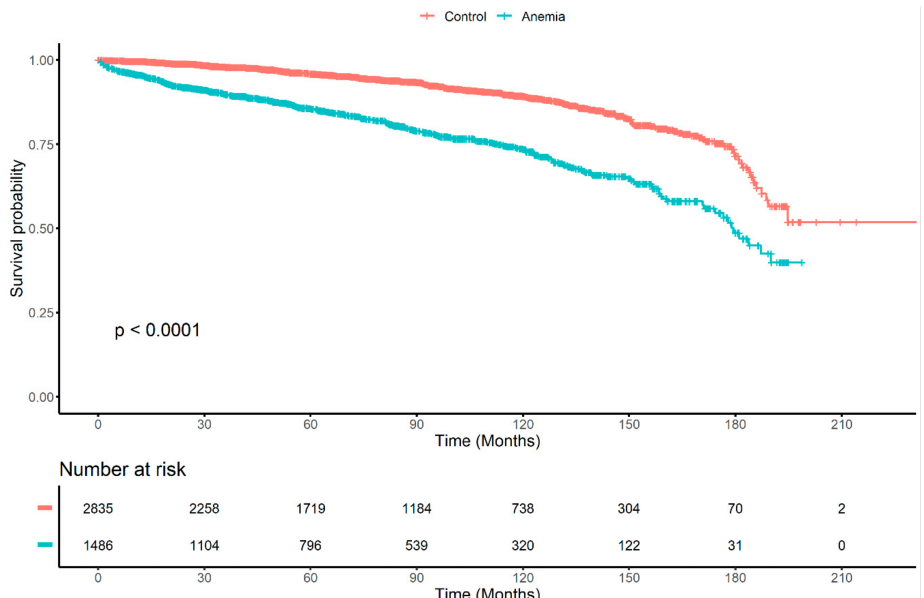
Figure 4. Kaplan–Meier survival analysis between anemia and control groups.